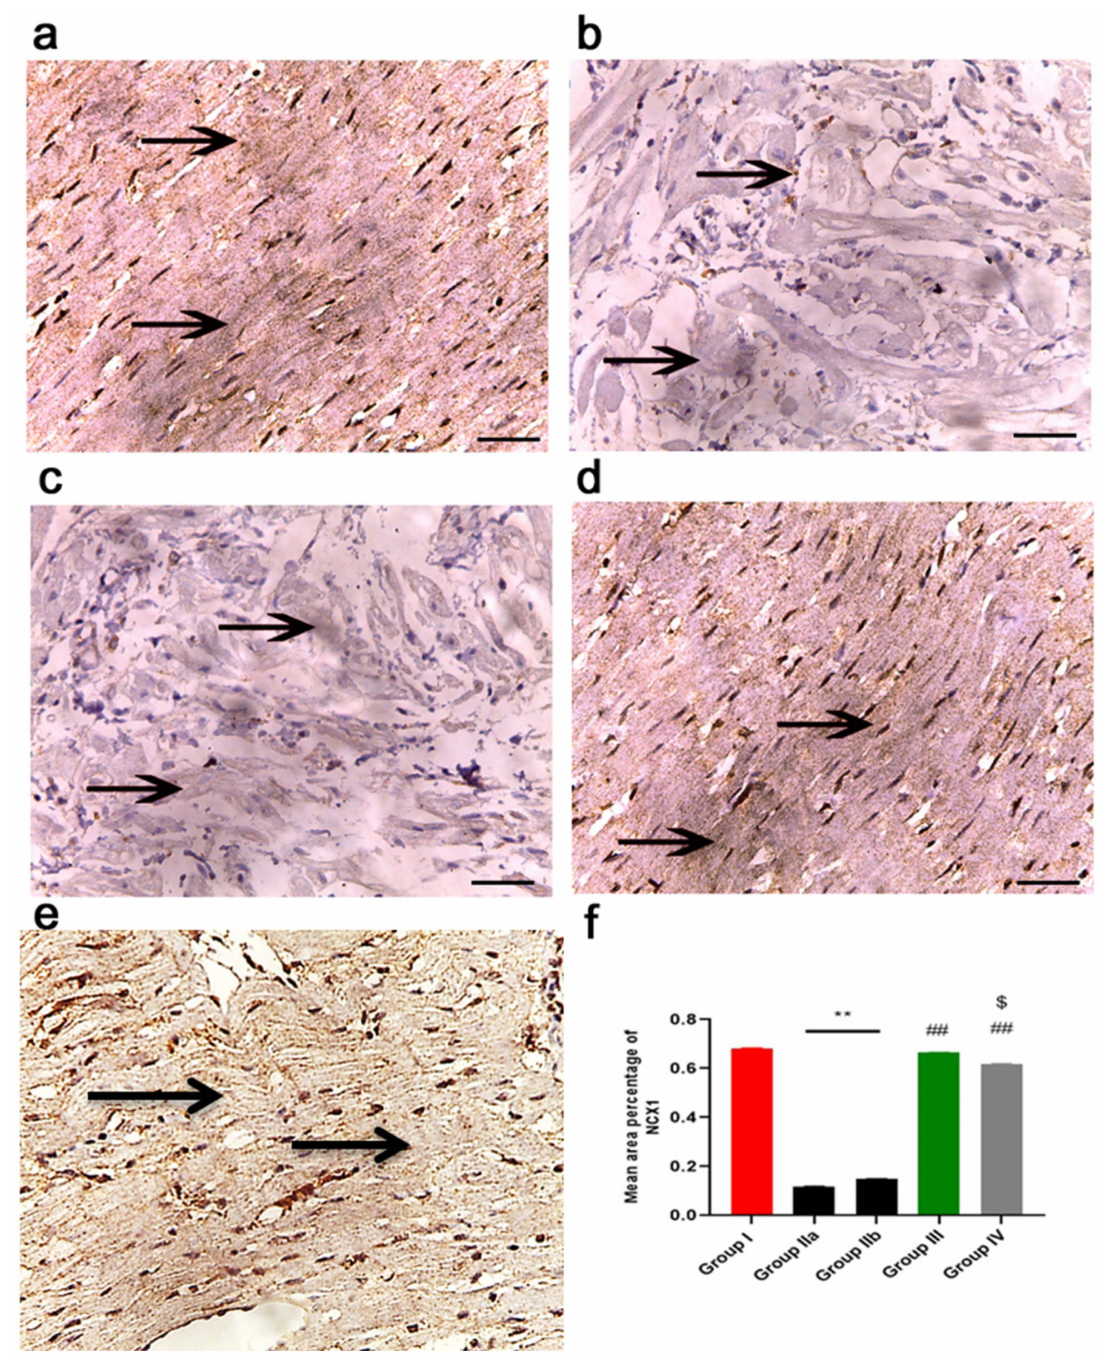
Figure 14. Representative photomicrographs of NCX1 immuno-stained sections from the left ventricle of the myocardium in the different experimental groups: ( a ) Group I (control group) showed strong immuno-expression of NCX1 in the myocardium; ( b ) Group IIa (DOX/Trz group) showed minimal immuno-expression of NCX1 in the myocardium; ( c ) Group IIb (recovery group) showed near- minimal immuno-expression of NCX1 in the myocardium; ( d ) Group III (prophylactic group) showed strong immuno-expression of NCX1 in the myocardium; ( e ) Group IV (curative group) showed moderate immuno-expression of NCX1 in the myocardium; and ( f ) Histogram representing the mean area percentage of NCX1 immuno-reaction in all experimental groups. **, significant compared to Group I at p < 0.01; ##, significant compared to Group II at p < 0.01; $, significant compared to Group III at p < 0.05; n =